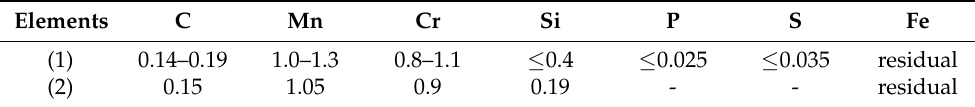
Table 1. Chemical composition of 16MnCr5 in wt.% (1) DIN EN10084 (2) supplier certificate and carrier hot gas extraction.